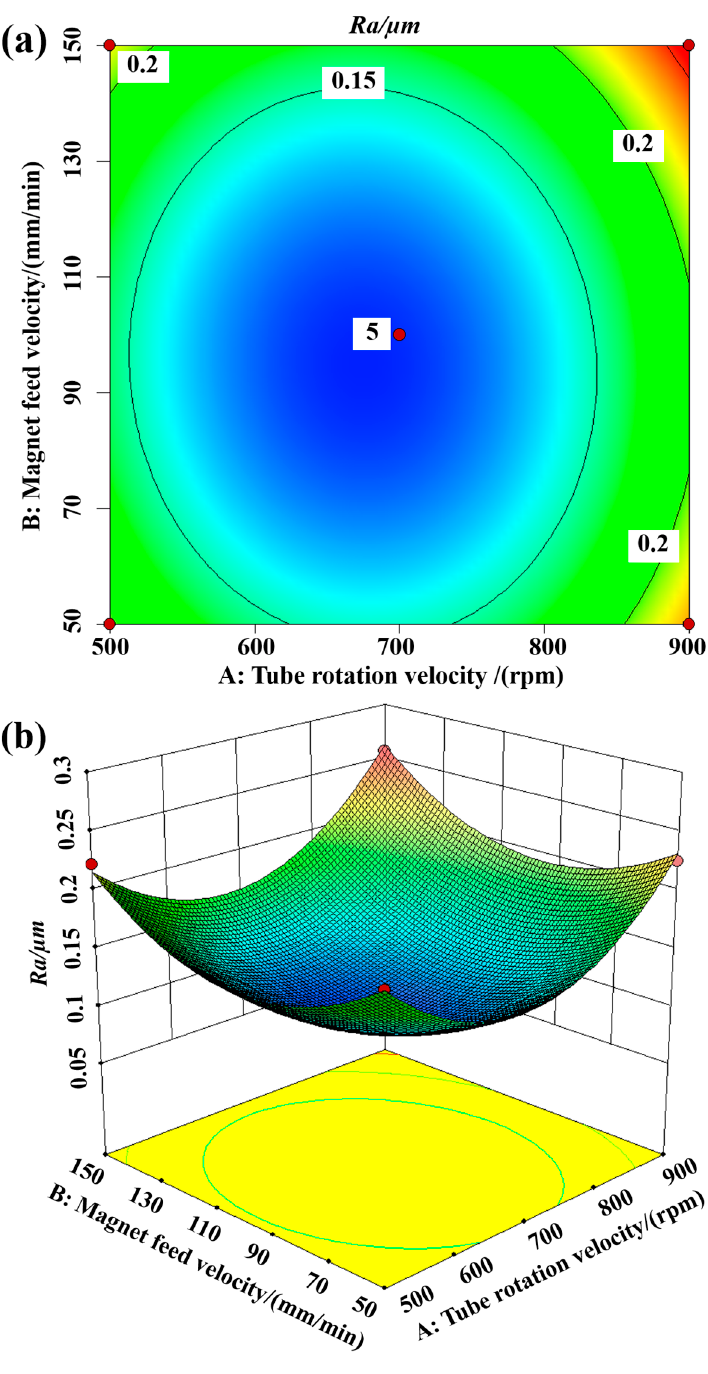
Figure 8. Interaction of tube rotation velocity and magnet feed velocity on surface roughness: ( a ) contour; ( b ) 3D response surface.